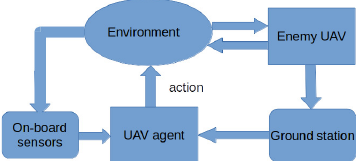
Figure 2. The decision making